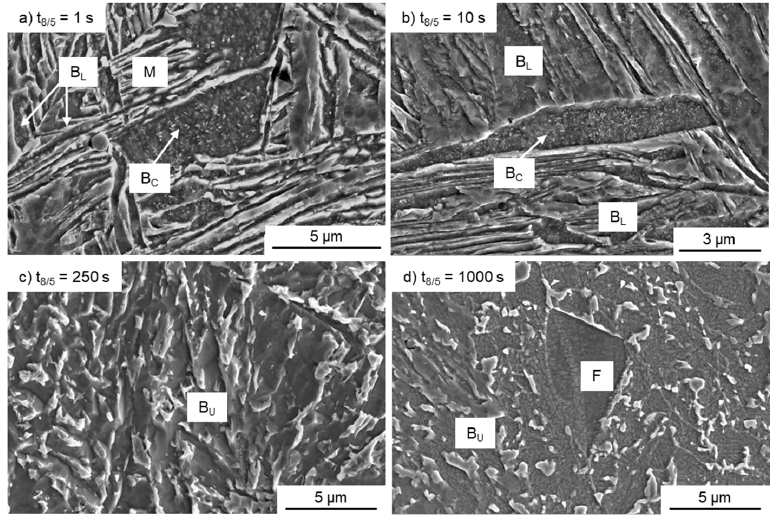
Figure 5. SEM images of the microstructure of the dilatometer specimens heated to 1400 °C peak temperature and cooled with different t 8/5 -times of ( a ) 1 s; ( b ) 10 s; ( c ) 250 s; and ( d ) 1000 s showing